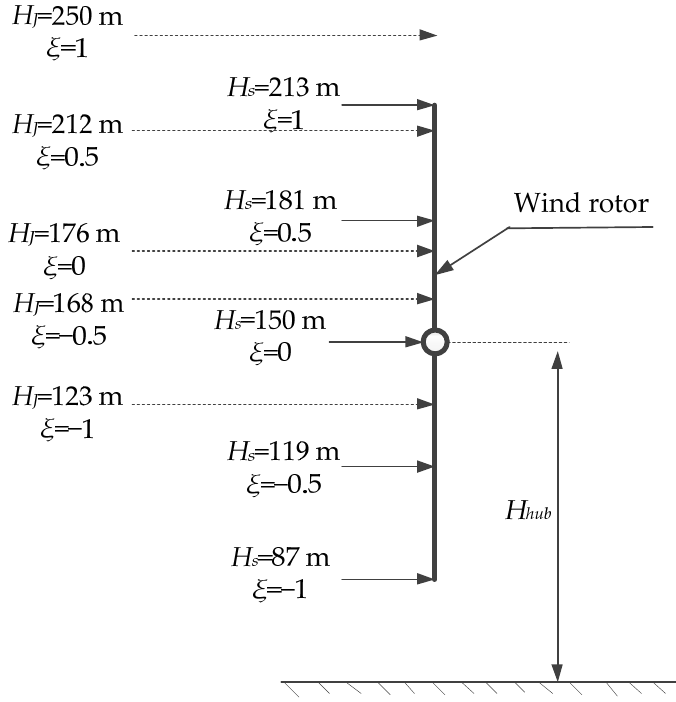
Figure 6. Schematic representation of the height of the free jet relative to the position of the wind rotor.